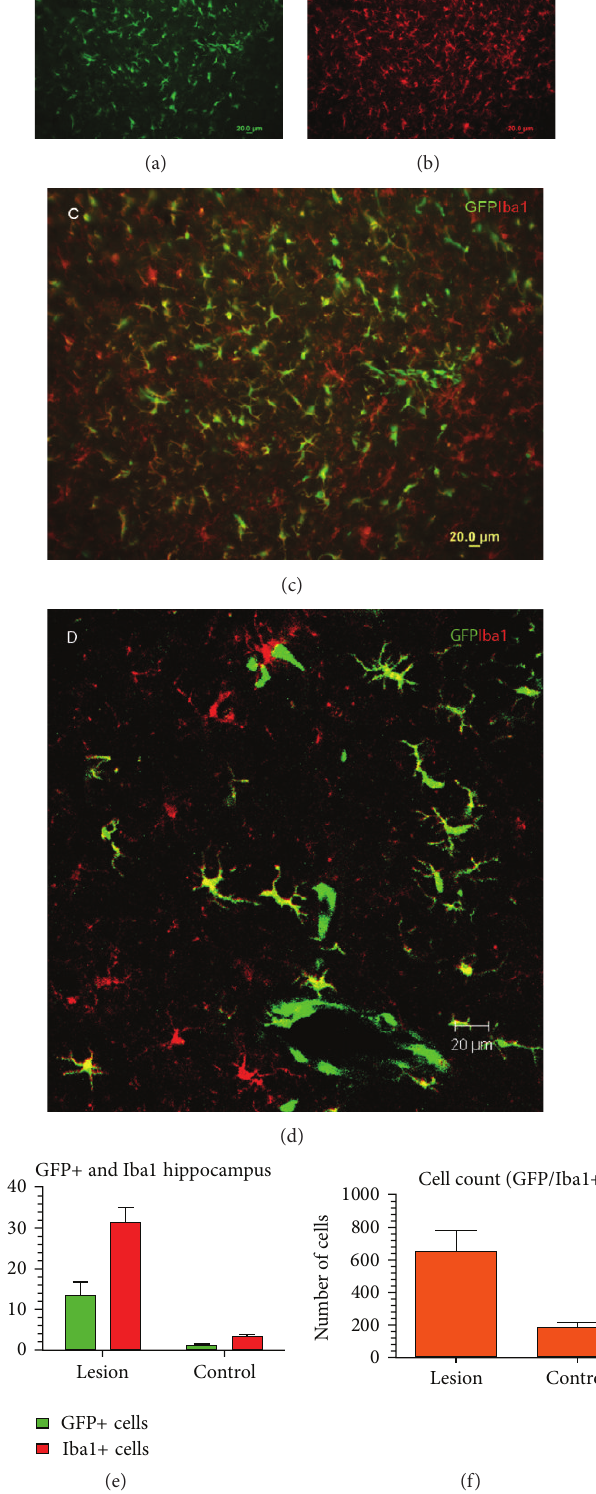
Figure 3: Contribution of blood-derived cells to microgliosis in chimeric mice 2 weeks after lesion placement. (a) Blood-derived GFP+ cells in hippocampal region. (b) Microgliosis two weeks after the lesion is indicated by Iba1 immunoreactivity. (c) Merged images of GFP+ (A) and Iba1+ cells (B). (d) Merged confocal image showing double-labeled microglia (yellow) at a higher magnification. (e) Mean Iba1 and GFP+ signals. On the lesioned side, the mean GFP+ signal is 26% of the total Iba1 signal (ratio of 13.4/51.6). (f) Cells count of double-labeled Iba1/GFP cells is significantly greater on the lesioned side than